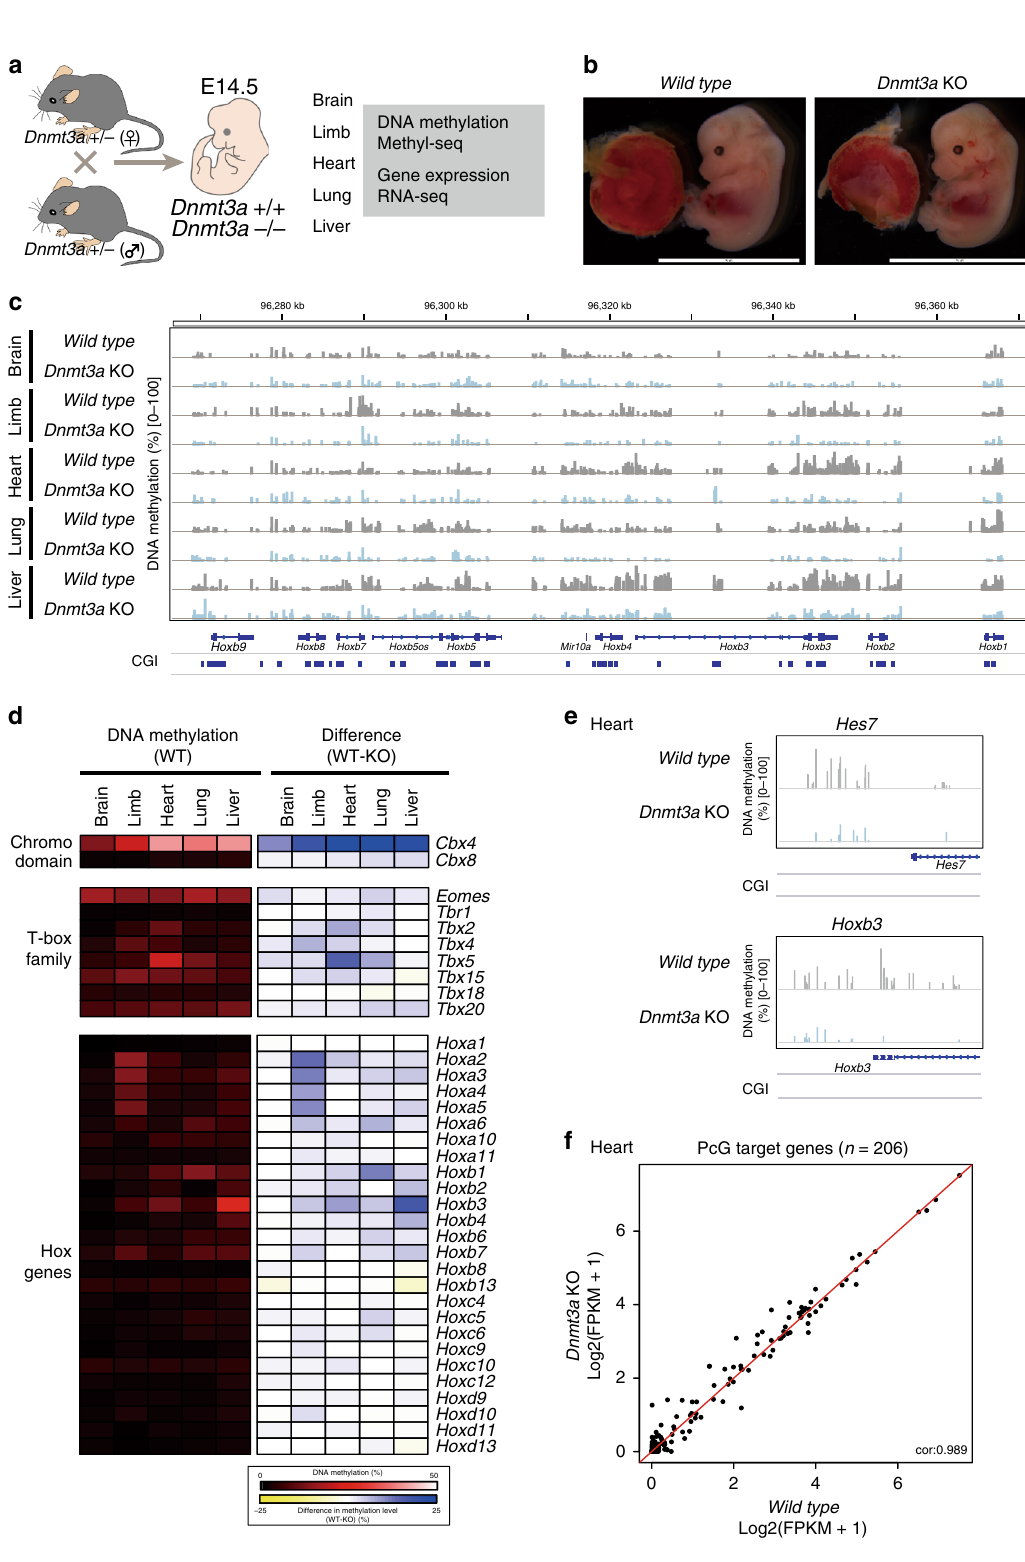
region speci fi city of de novo methylation by DNMT3A and DNMT3B is essentially shared between mice and